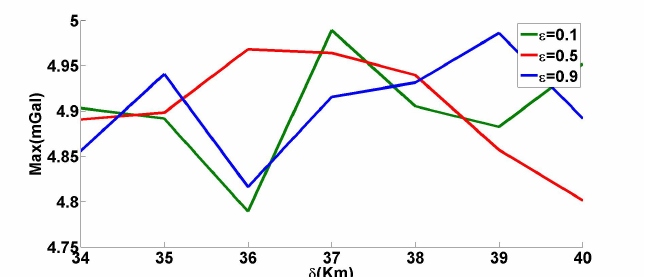
Fig. 5. Maximum of the differences between SMLS approximated values and those from shipborne gravimetry, as a function of δ , Gaussian weight function, ϵ = 0.1, 0.5,